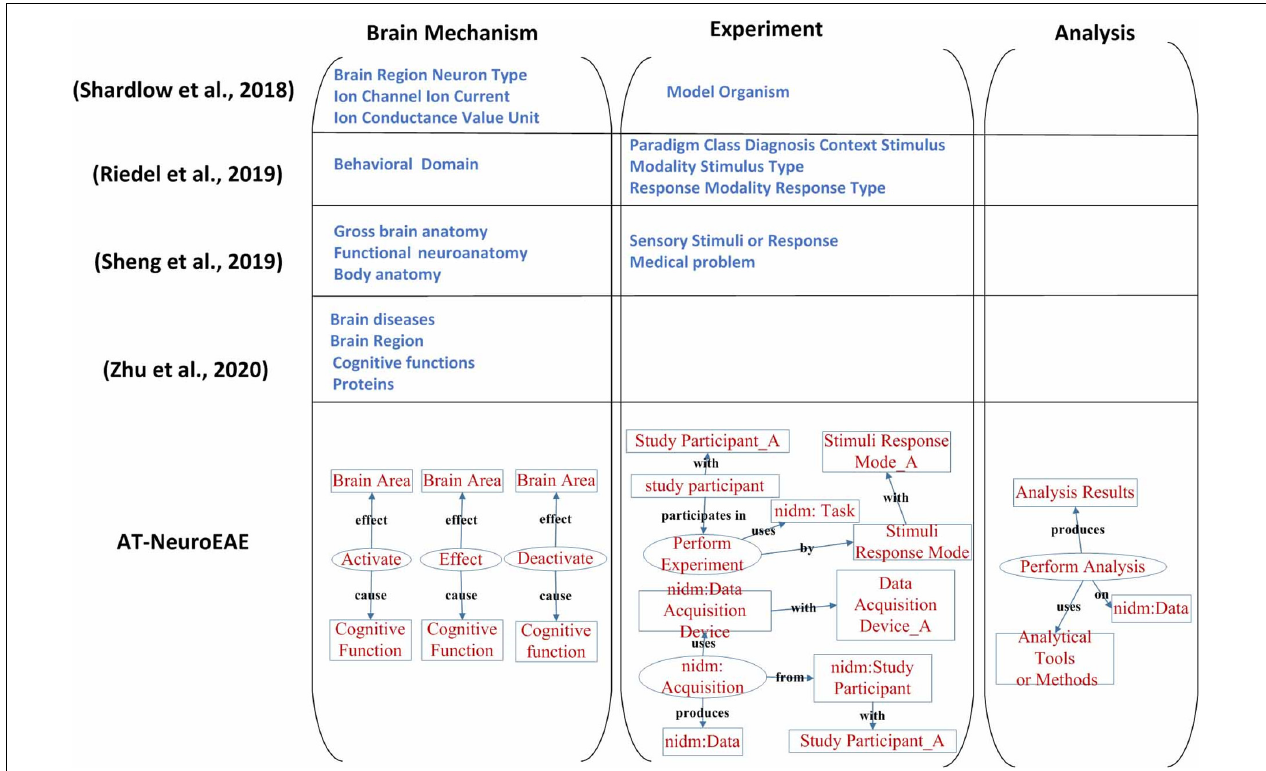
FIGURE 8 | A comparison of neuroimaging entity/label categories/span of interest. The study on Shardlow et al. (2018) mainly focused on brain mechanism, especially multi-level brain structures. The study on Riedel et al. (2019) only took account of the experimental process. The study on Sheng et al. (2019) focused on brain mechanism and two experimental factors, including sensory stimuli or response and study participants’ medical problems. The study on Zhu et al. (2020) paid attention on pathology and mechanism of brain diseases. Our study is involved with the whole research process and extracted information is organized by events with rich